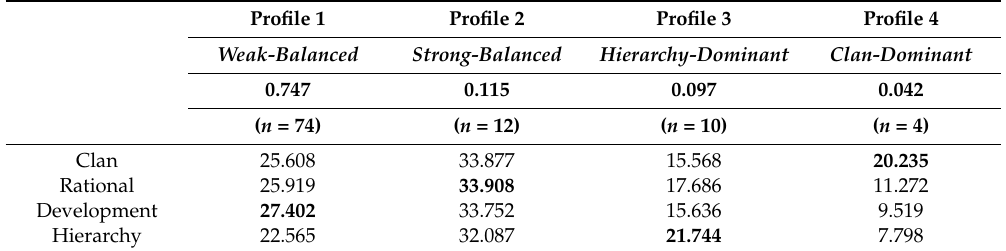
Table 3. Relative profile sizes and the mean scores within each latent